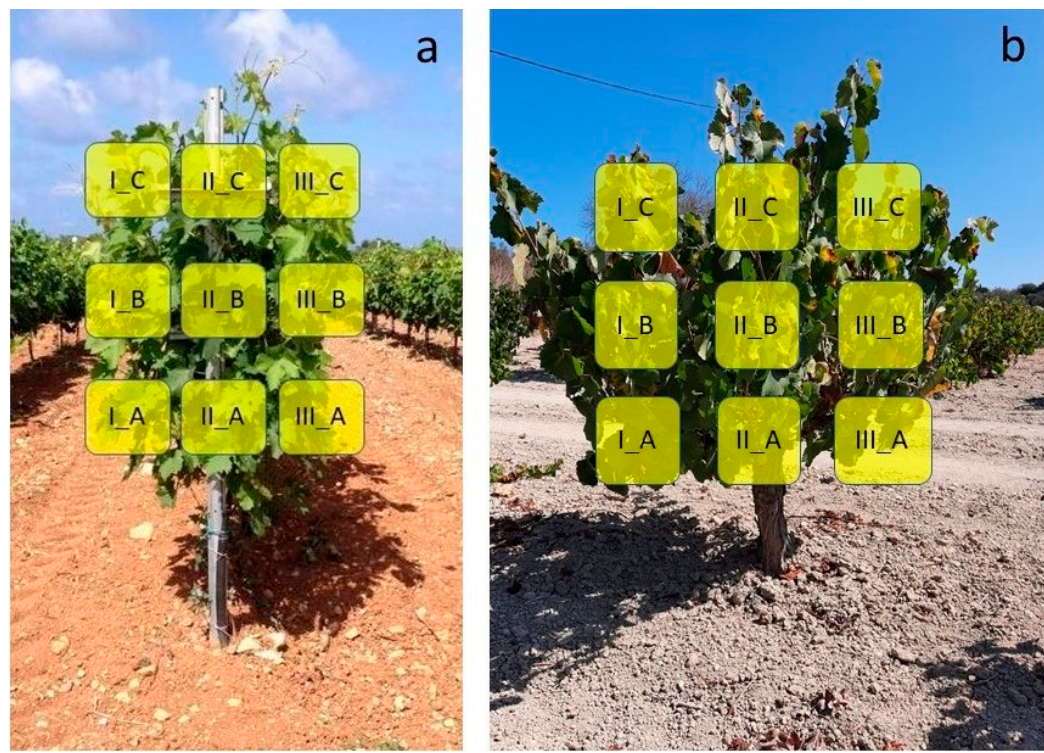
Figure 3. Leaf sampling positions for ( a ) Trellis trained vines and ( b ) Goblet trained vines. Leaves were taken from three heights (A–C) and three sides (I–III), resulting in nine leaf samples per vine.